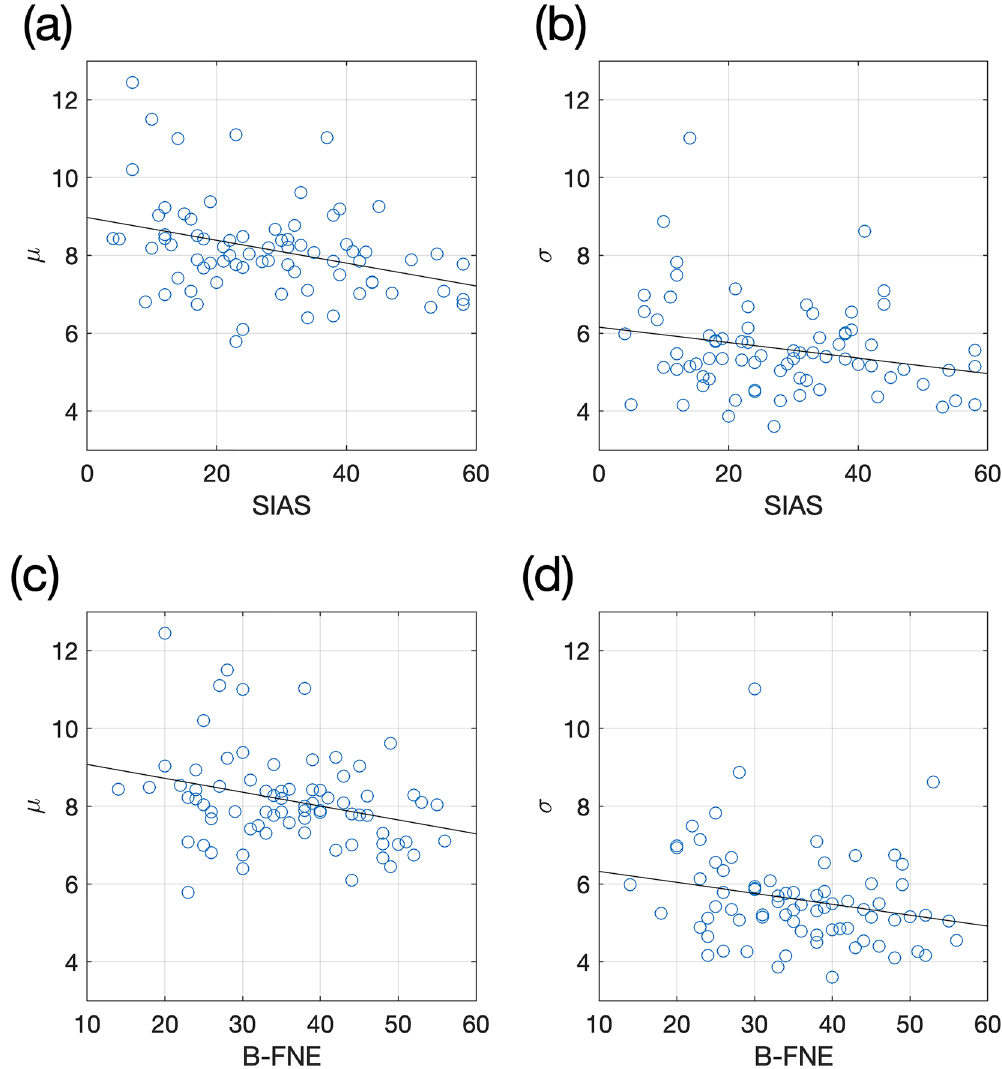
Figure 3. Social anxiety scores versus parameter estimates. Each data point represents one participant and solid line represents regression line in each panel. Both ( a ) SIAS and ( b ) B-FNE scores were negatively correlated with the mean of the psychometric function (μ). Both ( c ) SIAS and ( d ) B-FNE scores were also negatively correlated with the slope of the psychometric function